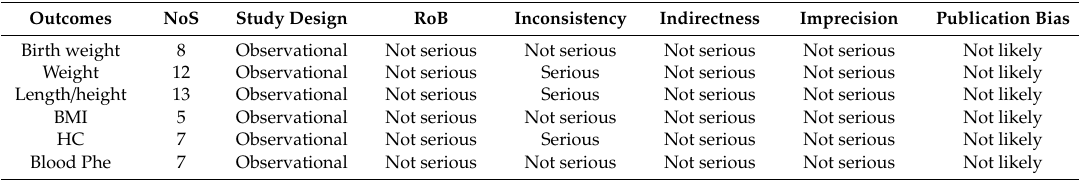
Table 3. Quality of studies according to Grading of Recommendations Assessment, Development and Evaluation (GRADE) system.